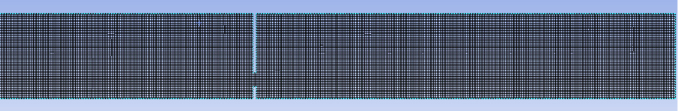
Table 5. Model size scheme.